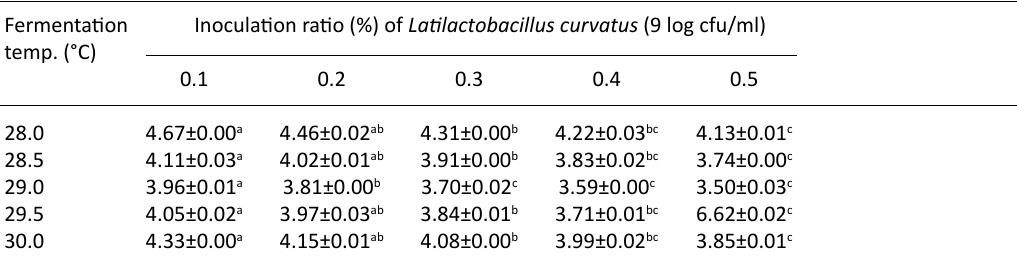
Table 2. pH of the pickled shrimp affected by inoculation ratio (%) of Latilactobacillus curvatus (9 log cfu/ml) and fermentation temperature (°C) after 6 weeks of fermentation Fermentation temp.